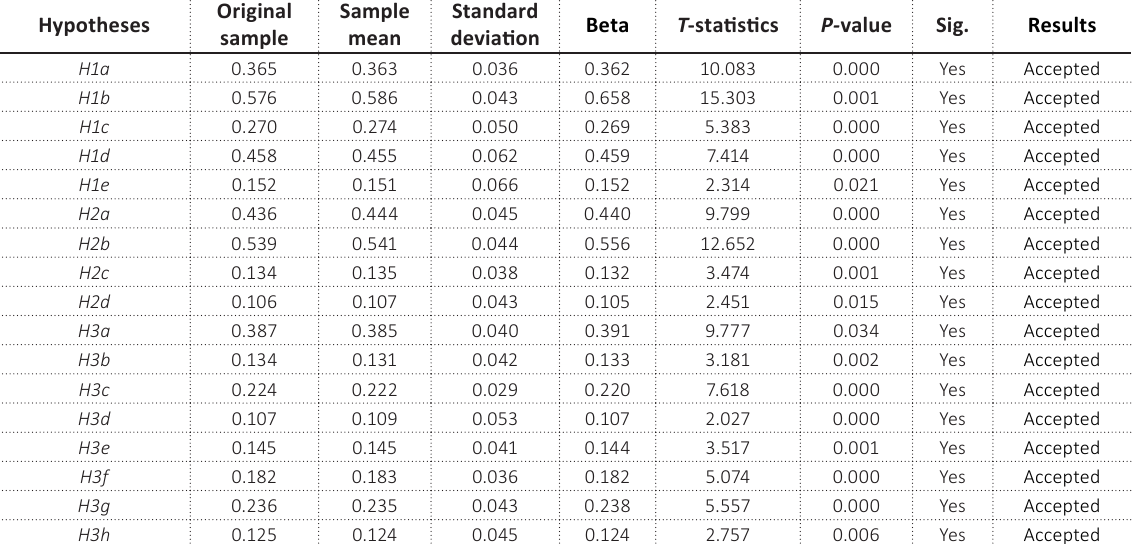
Table 5. Structural path